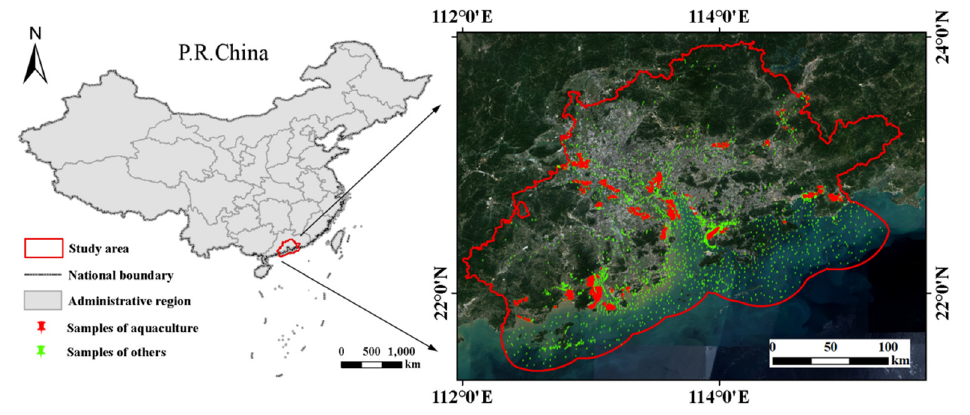
Figure 1. Geographical locations of the Pearl River Basin (Guangdong) and study area (annual median images of sentinel-2A (2020) after cloud removal).